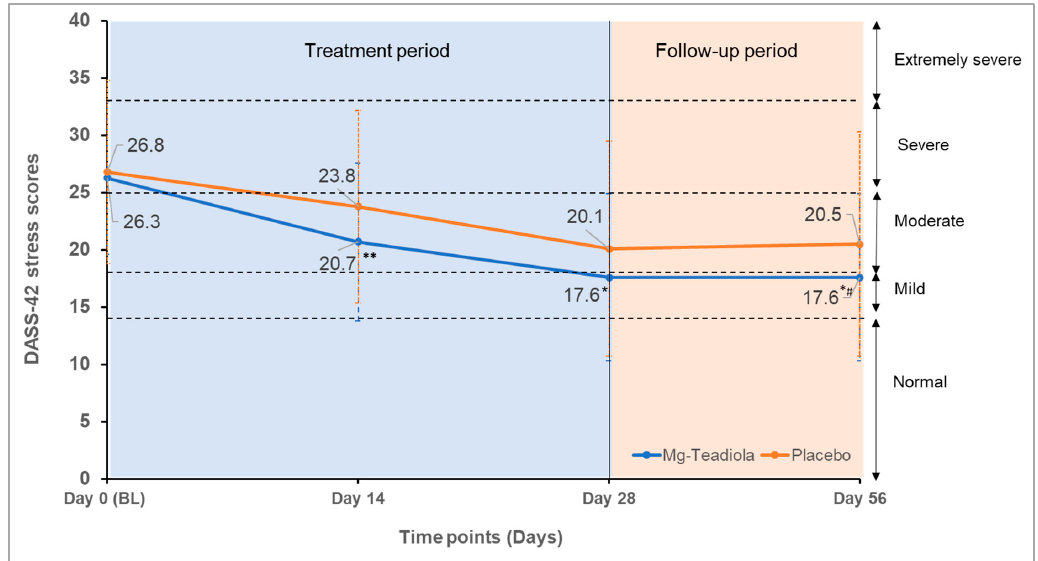
Figure 4. DASS-42 stress scores over time with Mg-Teadiola versus placebo. Mean (±SD) values are presented. Error bars represent SD. * p = 0.04 vs. Placebo; ** p = 0.006 vs. Placebo; * # p = 0.02 vs. Placebo. BL, baseline; DASS, Depression Anxiety Stress Scale; Mg-Teadiola, combination of 150 mg Mg, 0.7 mg vitamin B6, 0.1 mg vitamin B9, and 1.25 µ g vitamin B12, +222 mg of rhodiola extract and 125 mg of green tea extract including 50 mg of L-theanine; SD, standard deviation. Stress scores ranges: 0–14 (normal); 15–18 (mild), 19–25 (moderate); 26–33 (severe) and 34+ (extremely severe).